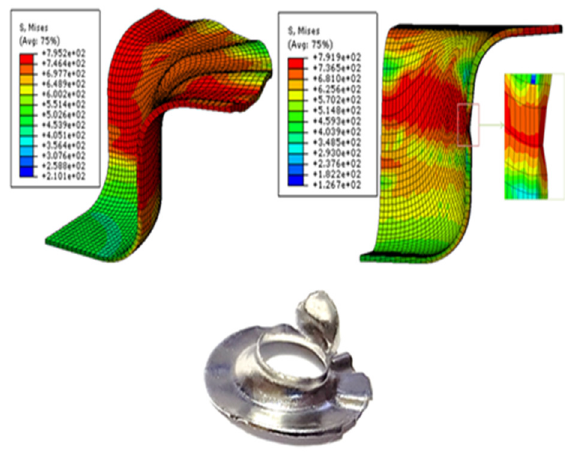
Fig. 12. Comparison the failure cups through simulation and experiment drawing.